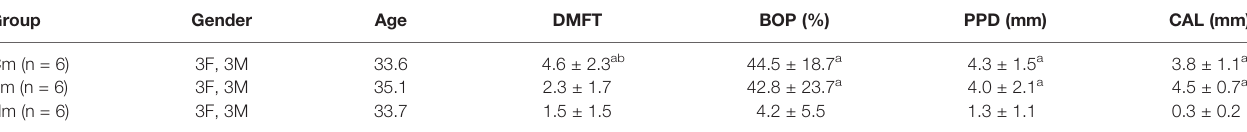
TABLE 1 | Clinical and demographic characteristics of the study